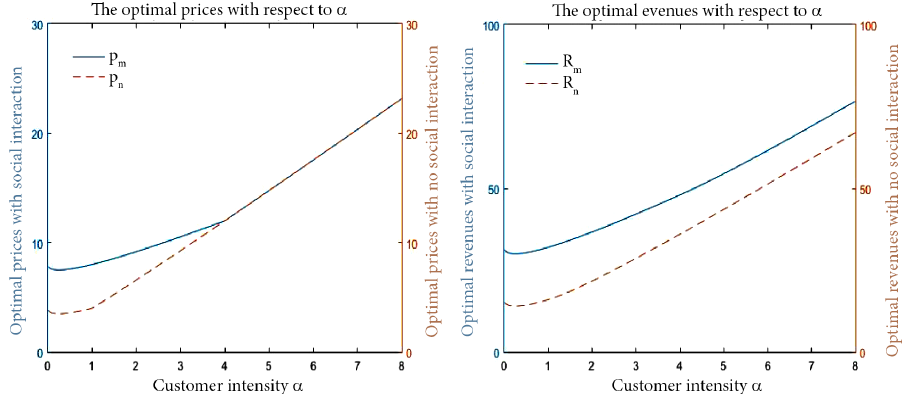
Figure 3. The left panel illustrates the optimal prices with respect to a with and without social interaction effect. The right panel illustrates the optimal revenues in equilibrium with respect to a with and without social interation